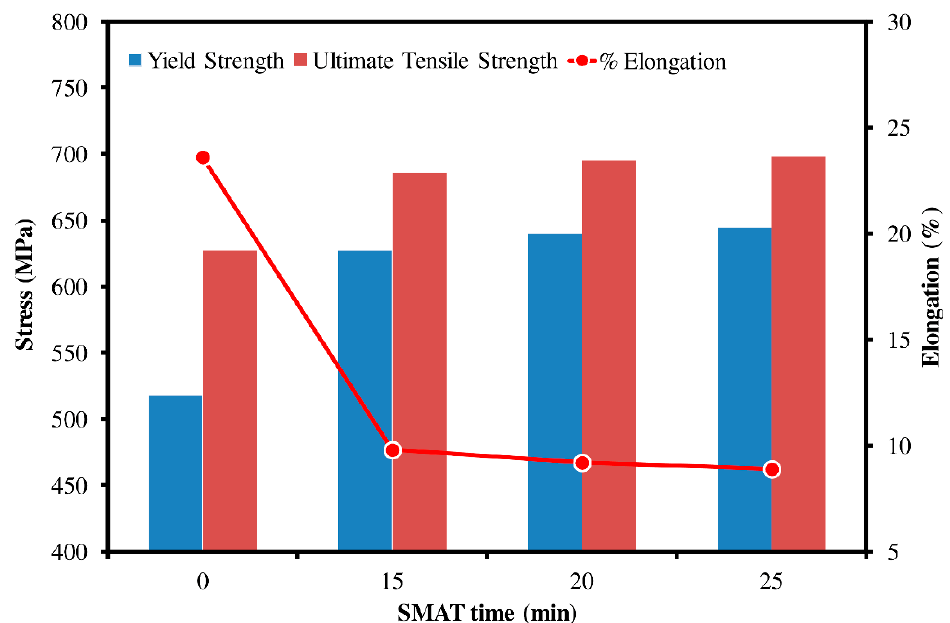
Figure 7. Mechanical properties of Ti samples as a function of SMAT